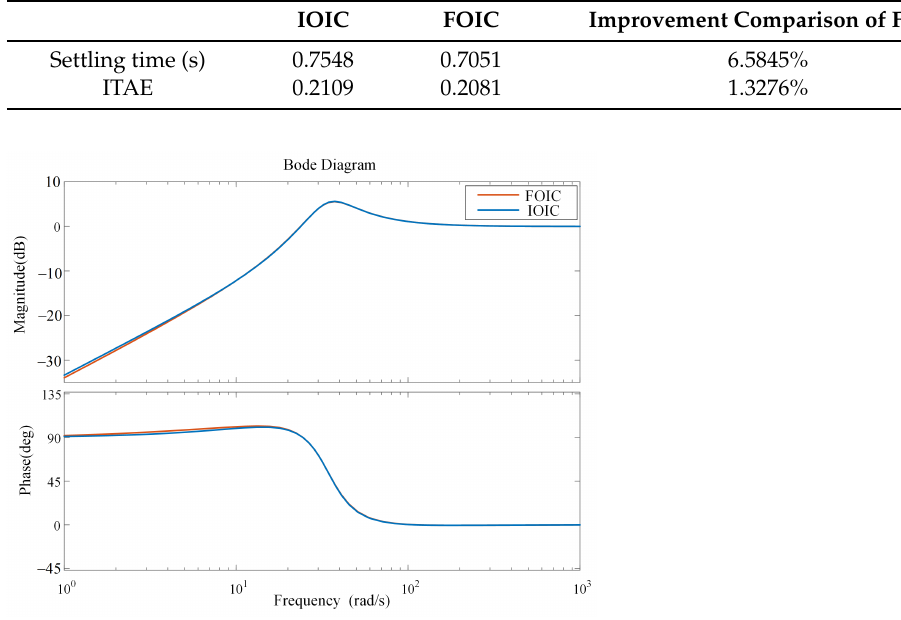
Figure 17. Bode sensitivity plot of FOIC and IOIC for robot manipulator control